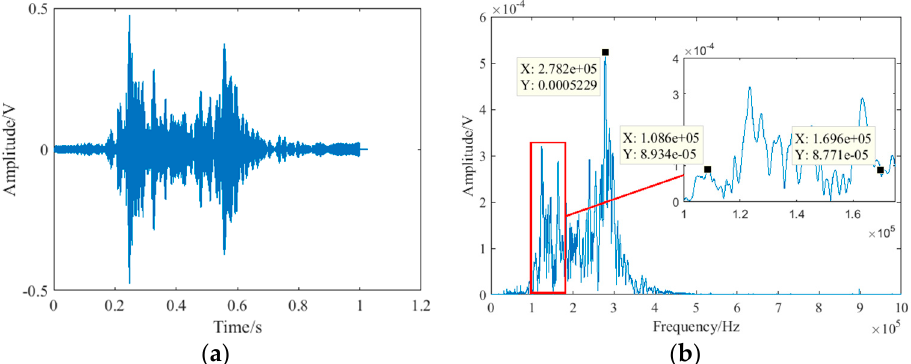
Figure 6. The received sweep signal: ( a ) time-domain; ( b ) frequency-domain.